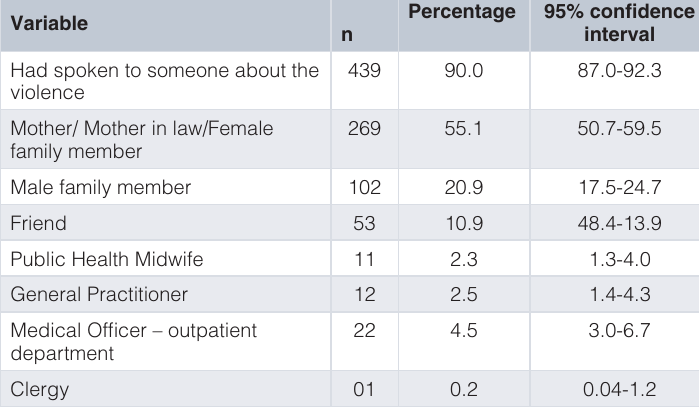
Table 8. Help-seeking behavior of the women